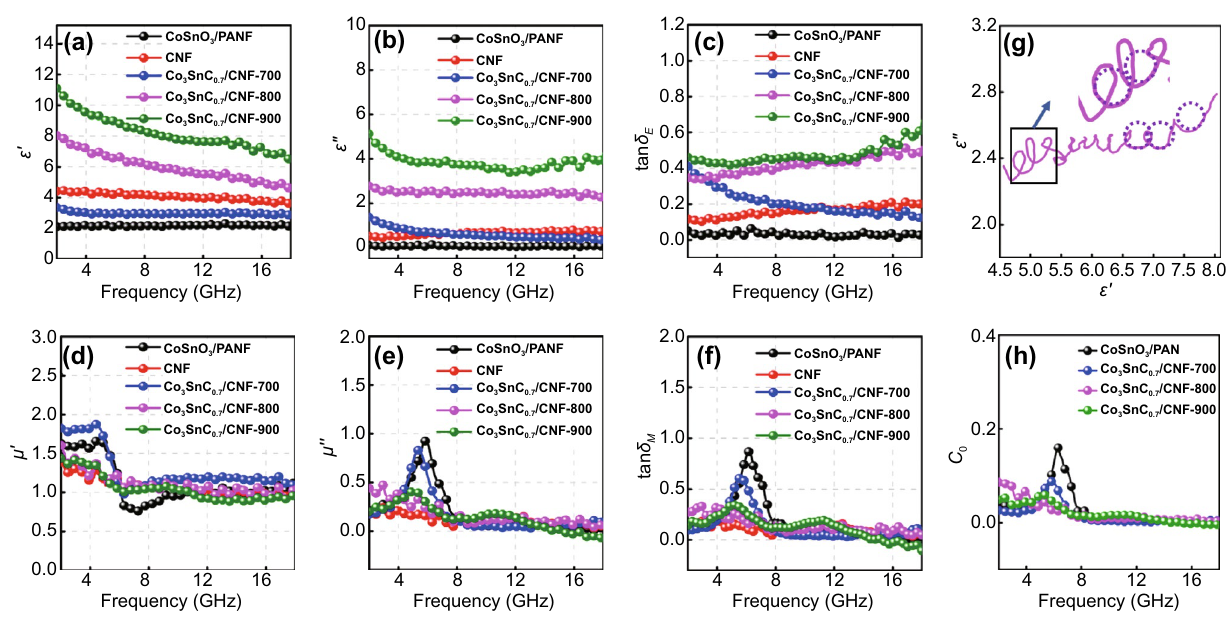
Fig.4 Real part ( a ) and imaginary part ( b ) of permittivity; the curves of tan δ E ( c ); the real part ( d ) and imaginary part ( e ) permeability; the curves of tan δ M ( f ); the Cole–Cole curve ( g ) of Co 3 SnC 0.7 /CNF-800 and the C 0 curve ( h ) of CoSnO 3 /PAN, Co 3 SnC 0.7 /CNF-700, Co 3 SnC 0.7 / CNF-800,